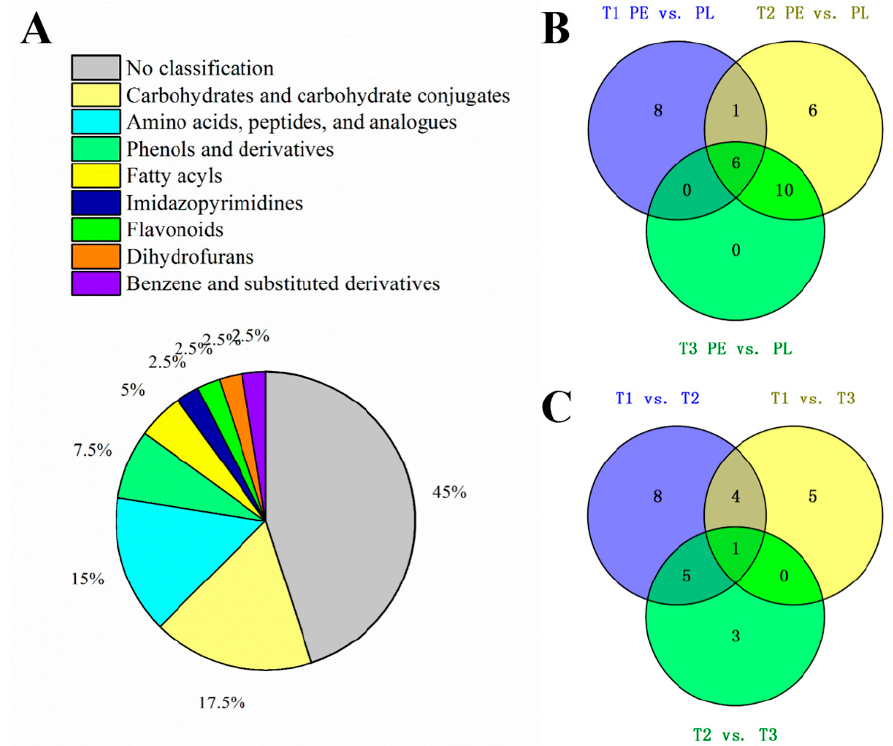
Figure 2. Pie chart ( A ) showing di ff erential metabolite classification. Venn diagrams showing the shared di ff erential metabolite numbers of di ff erent tissues ( B ) and treatments ( C ). T1, NH 4 + :NO 3 − = 0:100; T2, NH 4 + :NO 3 − = 25:75; T3, NH 4 + :NO 3 − = 50:50, PE, pericarp; PL,